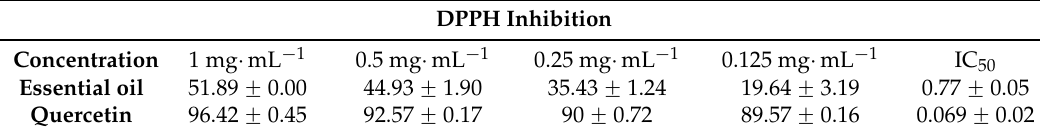
Table 2. DPPH radical scavenging activity of Teucrium pseudochamaepitys essential oil.